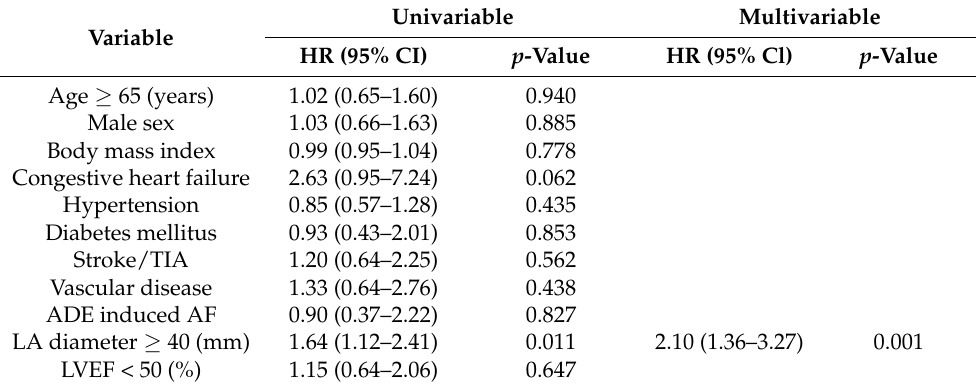
Table 2. Cox-regression analysis for recurrence of atrial arrhythmia after RFCA.